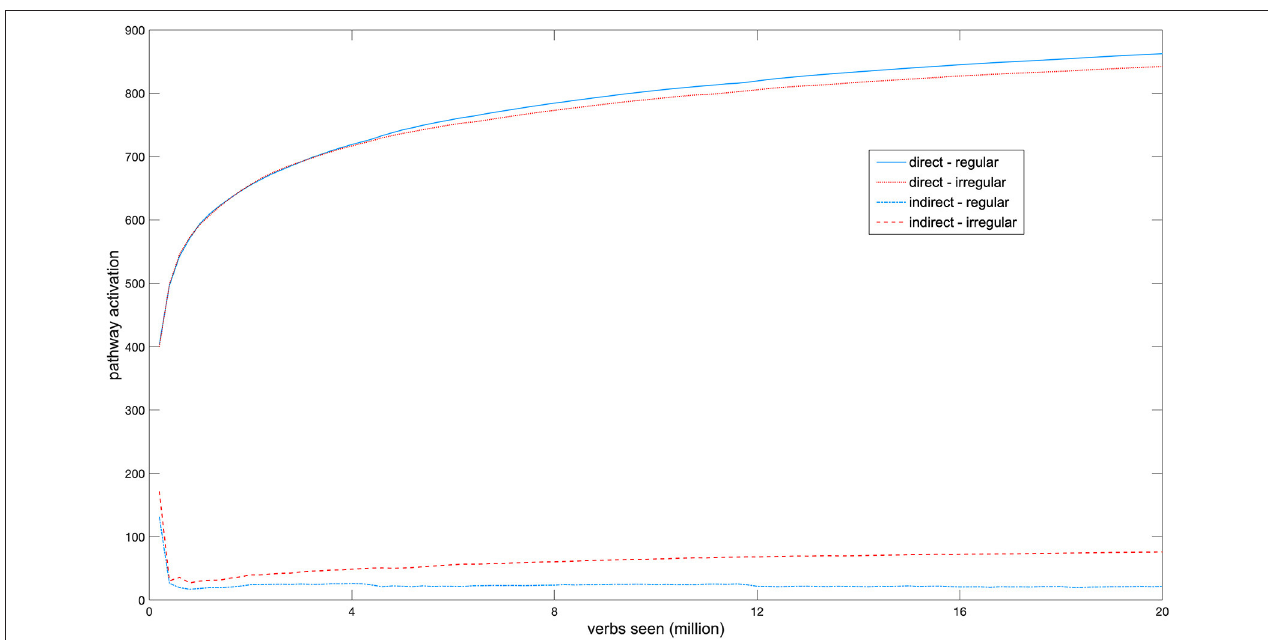
FIGURE 2 | Development of the activation profiles of regular and irregular verbs in both network